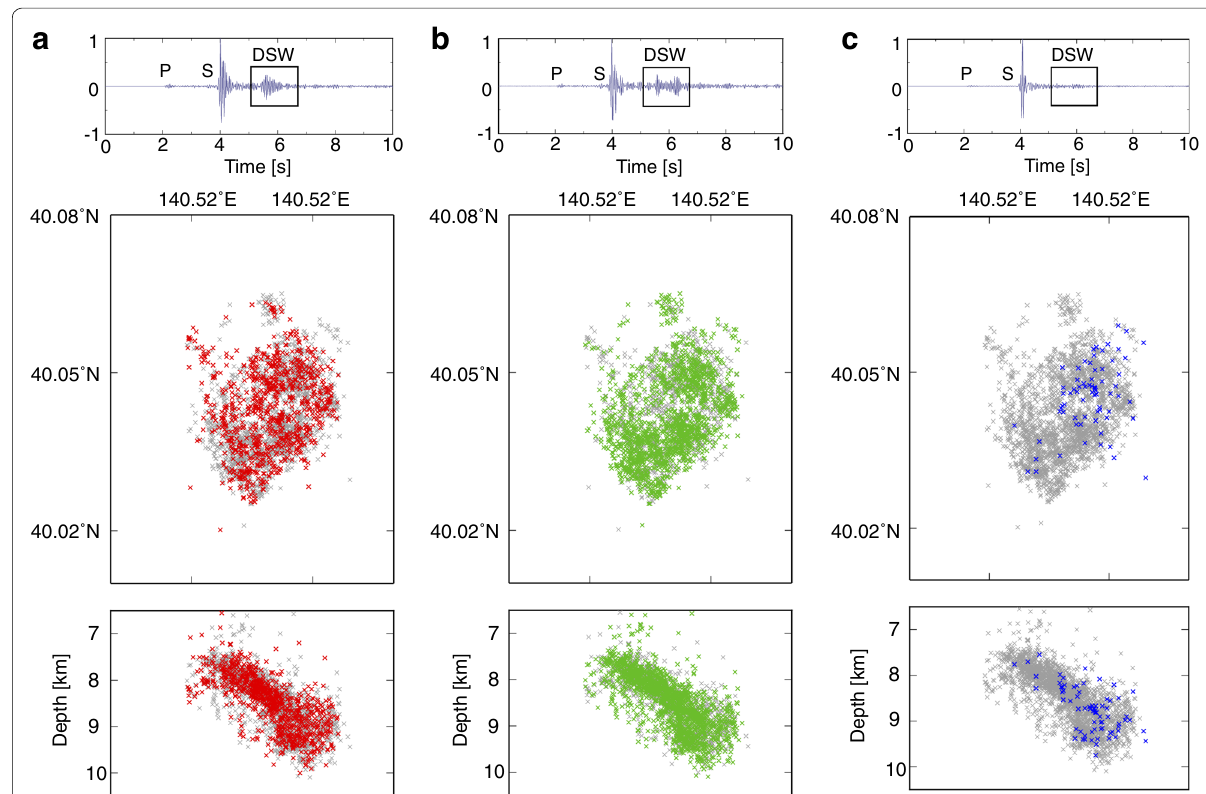
Fig. 3 Three types of DSW and the corresponding hypocenter distribution. Top figures represent seismograms with DSW classified as a single peak ( a ), double peaks ( b ), and unclear ( c ), respectively. Middle and bottom figures show epicenter and depth distribution of earthquakes. Colored and gray crosses denote the hypocenters of each type of DSW and whole earthquakes,